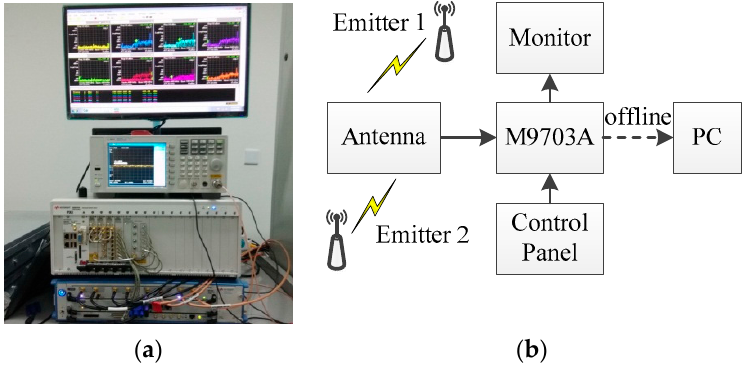
Figure 9. Real signal sampling experiment. ( a ) Sampling the signals from two emitters. ( b ) Process of signal sampling and signal processing.